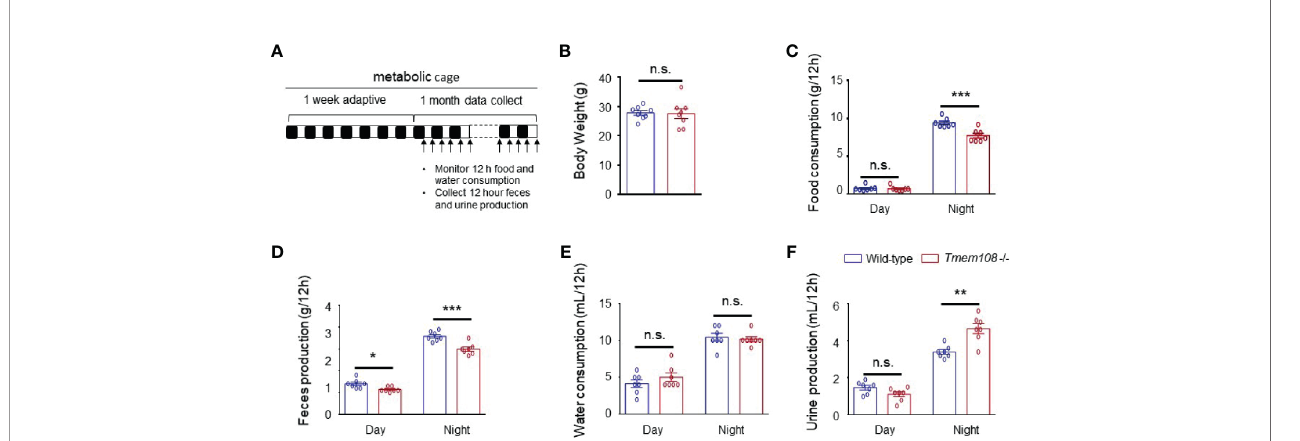
FIGURE 2 | Tmem108 de fi ciency changed food and water metabolic level. (A) Schematic diagram for the collection of excreta and monitoring of food/water consumption. Alternating white and black bars show the alternate of day and night. (B) Body weights of 3-month mice were not affected by Tmem108 mutant ( Tmem108 -/-), wild-type mice as the control (n = 8 per group). (C – F) . The measurement was obtained from metabolic cage experiments. Food (C) and water consumption (E) and feces (D) and urine production (F) are shown as means ± SEM, which were normalized to body weights (n = 7 per group, unpaired t -test, *p < 0.05, **p < 0.01, ***p < 0.001). n.s., not signi fi